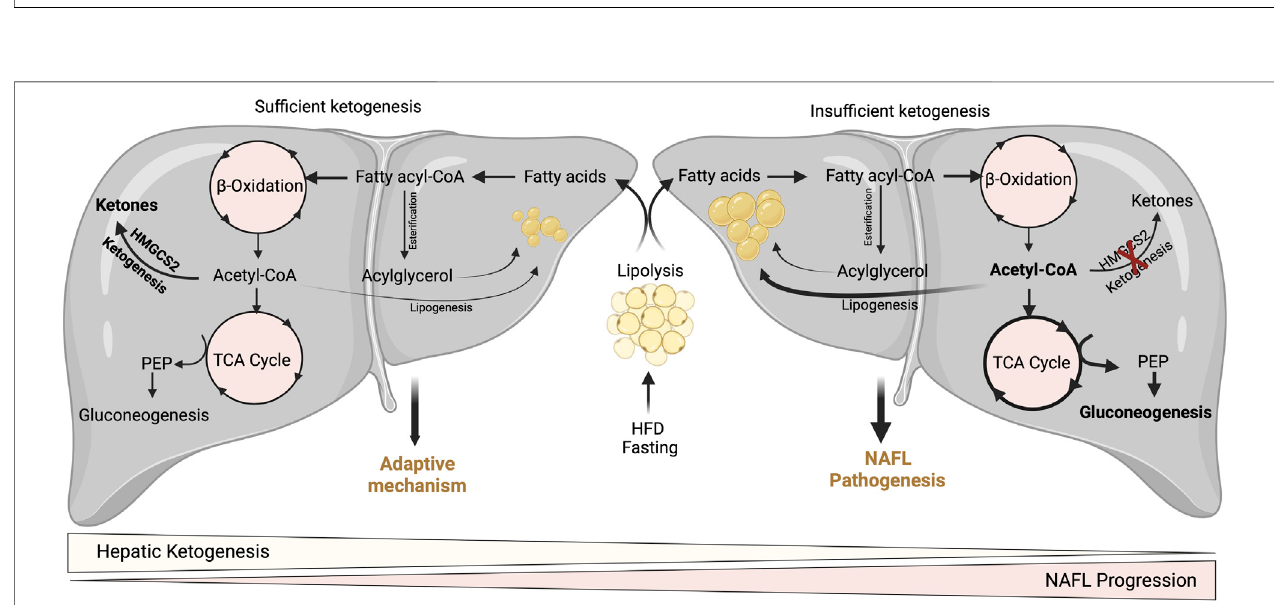
FIGURE 3 | Adaptive and pathological signi fi cance of hepatic ketogenesis in NAFL. Under hepatic ketogenesis suf fi cient conditions, the increased fatty acid entry into the liver during fasting and HFD can ef fi ciently enter into ketogenesis pathway and protects from excessive accumulation of lipids and thereby lipotoxicity. On the other hand, under insuf fi cient hepatic ketogenesis condition, the excess fatty acids result in the accumulation of acetyl-CoA and enter to TCA cycle, and thereby increasing gluconeogenesis and DNL. Thus, continuous accumulation of fatty acids results in lipotoxicity and NAFL progression.